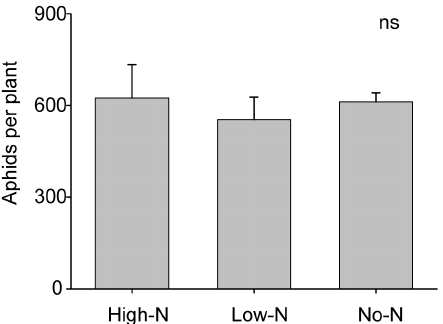
Figure 5. Effects of dependence on rhizobial N by 5-week old soybeans, on the population growth of soybean aphids over 8 days (starting from 15 adults per plant). High-N = High N fertilizer treatment, Low-N = Low N fertilizer treatment, and No-N = no fertilizer. “ns” indicates no significant difference. Results shown as means ±